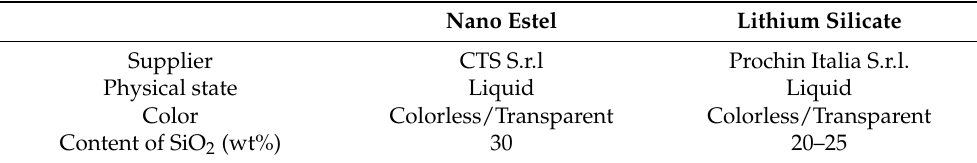
Table 1. Main properties of the two consolidants